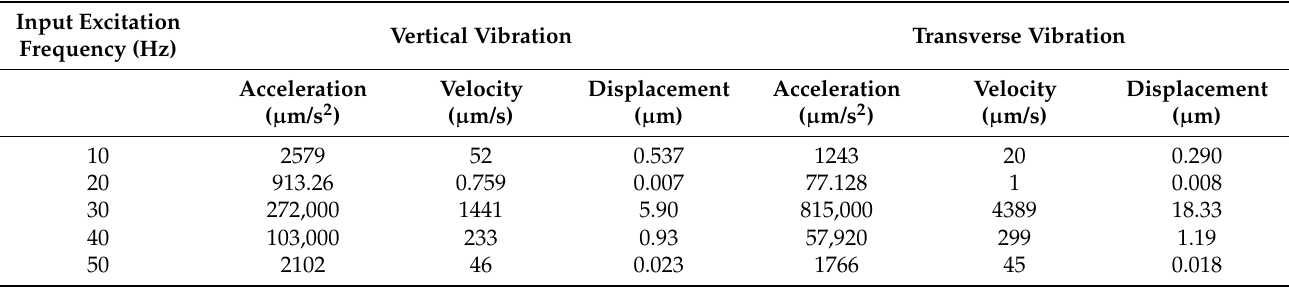
Table 3. Peak amplitude of vibration in vertical and transverse direction for confined granular